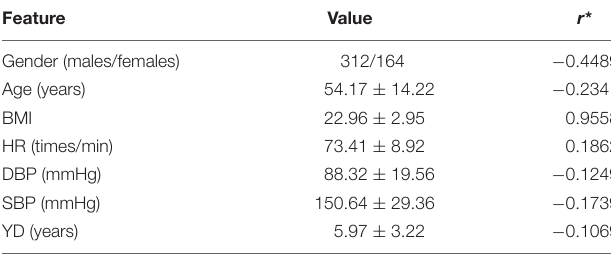
TABLE 1 | She summary information of patients.